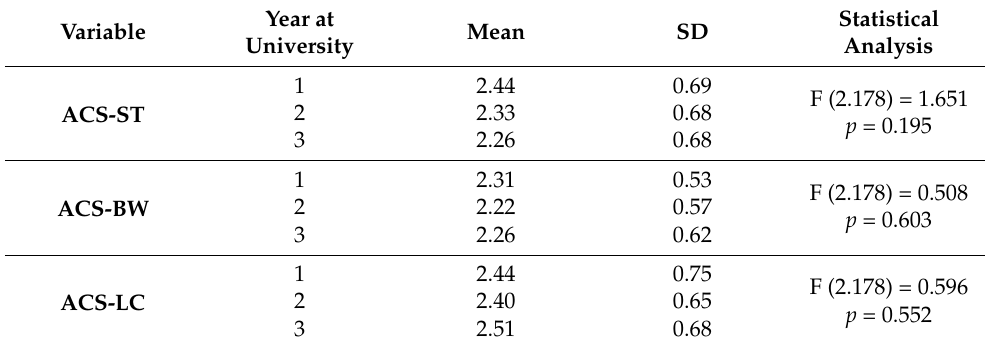
Table 3. Characteristics of conditioning and development of nursing competences (ACS-ST, ACS-BW, ACS-LC) over the 3-year education cycle on the level of first-degree study. Year Variable